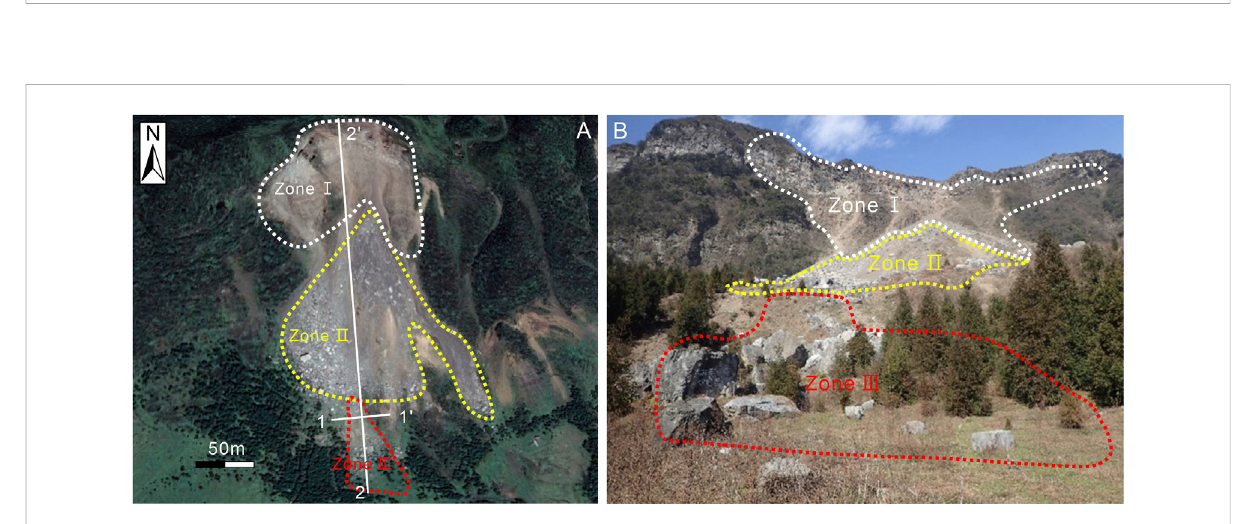
FIGURE 5 Overall features of the rockfall-dominated talus slope: (A) plane view (image source: Google Earth) and (B) front